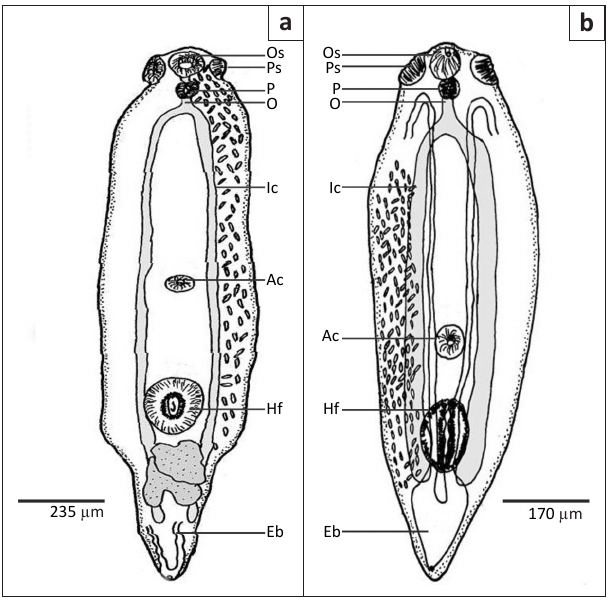
FIGURE 1: Light microscope projection drawings, (a) Diplostomid metacercaria A [ Diplostomulum ( Tylodelphys ) mashonense ] from the cranial cavity of Clarias gariepinus collected from Boekenhoutskloof farm dam and (b) Diplostomid metacercaria B from the vitreous chamber of Tilapia sparrmanii and Pseudocrenilabrus philander collected from Supersand dam, Gauteng